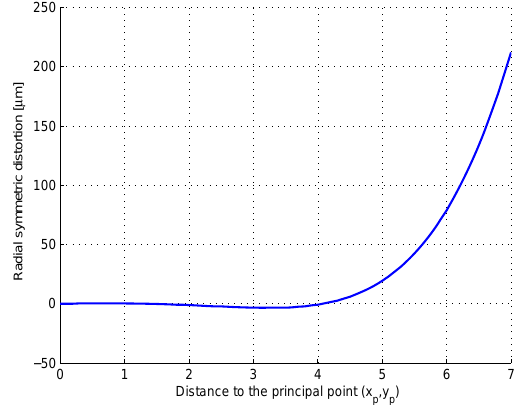
Figure 5: Radial symmetric distortion of the thermal camera FLIR Tau 640.